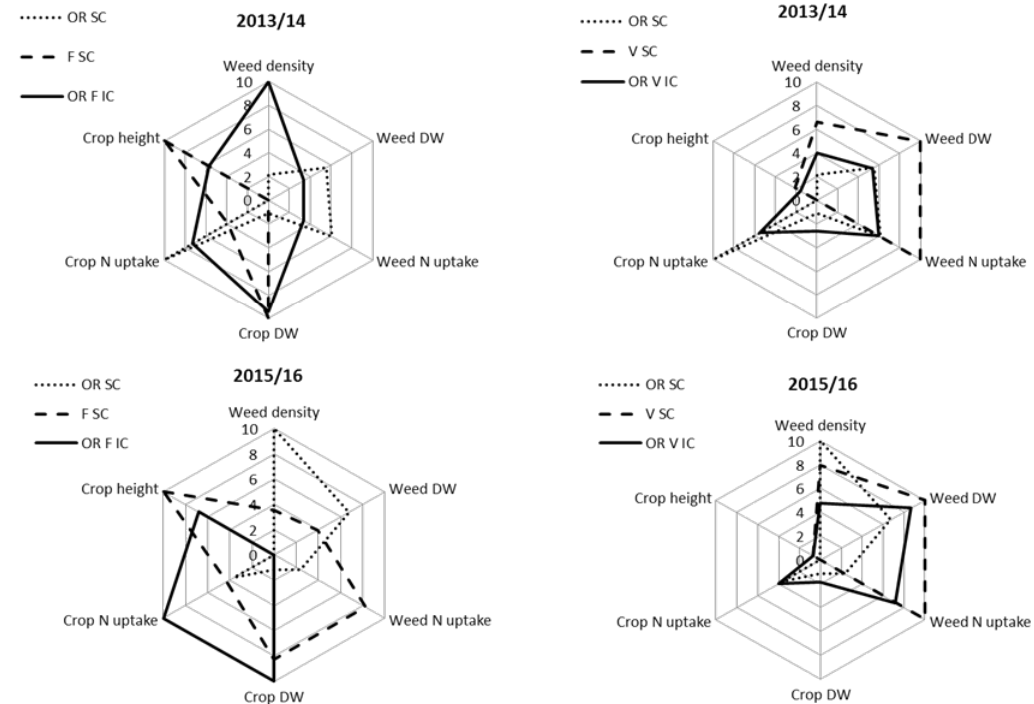
Figure 5. Comparison between the sole crops and intercropping on crop growth (height and crop dry matter) and soil N uptake and their effects on weed suppression after winter in February by using radar plots for each experimental year in 2013/14 and 2015/16. Oilseed rape sole crop (OR SC), faba bean sole crop (F SC), common vetch sole crop (V SC), and oilseed rape intercropped with faba bean (OR F IC) or common vetch (OR V IC). Weed DW and weed N uptake indicate the proportion (%) of weed aboveground biomass and weed aboveground N in the total (weeds and crops), respectively. Crop N uptake indicates the quantity of N derived from soil by crop (kg ha − 1 ). Crop DW indicates the quantity of aboveground biomass produced by crop (t ha − 1 ). ICs and SCs were compared each year for several variables (crop traits and weed infestation) by radar plots using scores calculated for each variable and for each year separately through the minimum (min) and maximum (max) observed values as follows: Score = 10 ∗ (value − min)/(max − min).